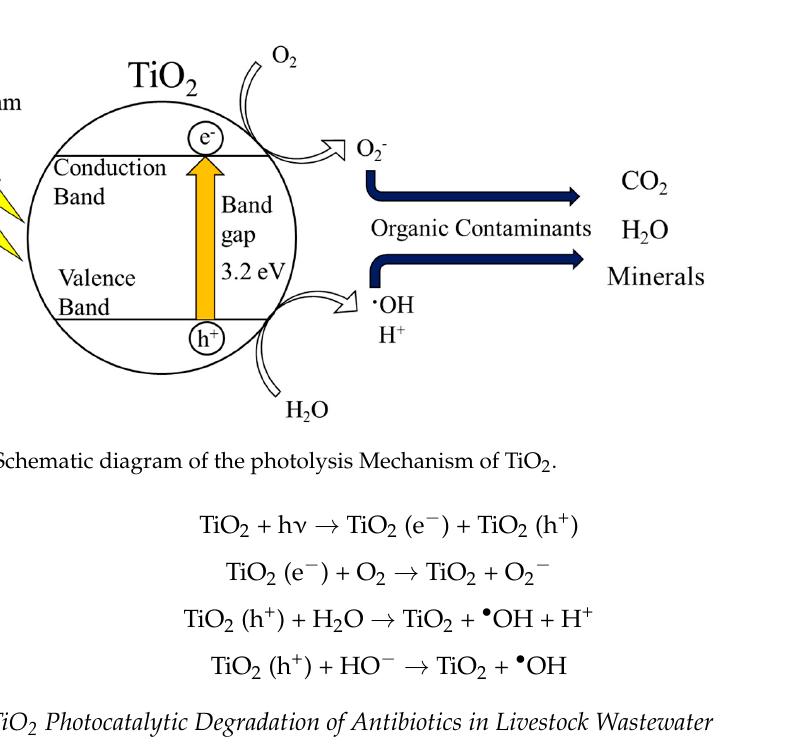
Figure 2. Characterization of TiO 2 : ( a ) SEM analysis, ( b ) XRD analysis, and ( c ) TEM analysis (insert: HR-TEM analysis) and ( d ) FTIR analysis.